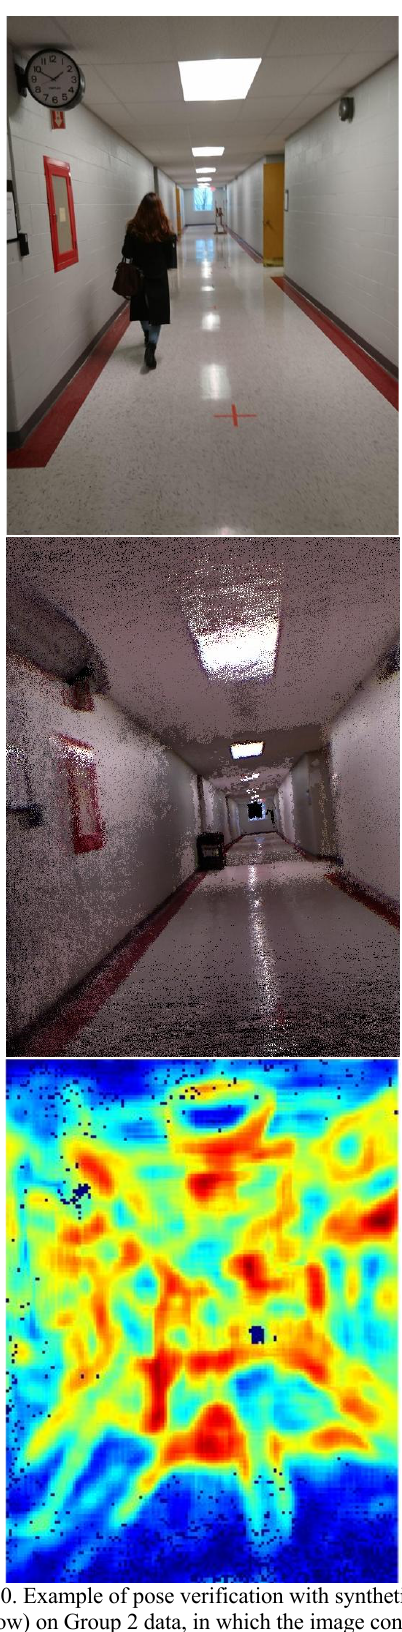
Figure 10. Example of pose verification with synthetic image (2nd row) on Group 2 data, in which the image contains a moving person (1st row) and error